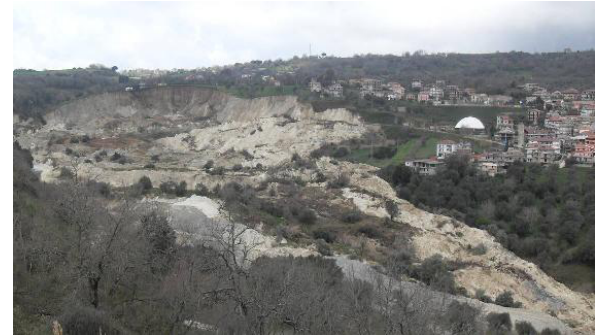
Figure 2. Panoramic view of the Maierato Landslide